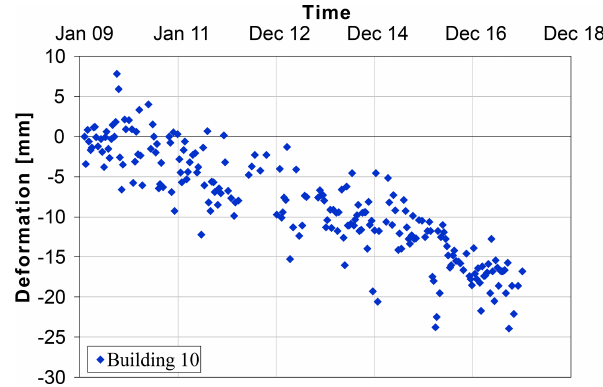
Figure 1. Typical examples of levelling time series. Figure 2. Typical examples of InSAR time